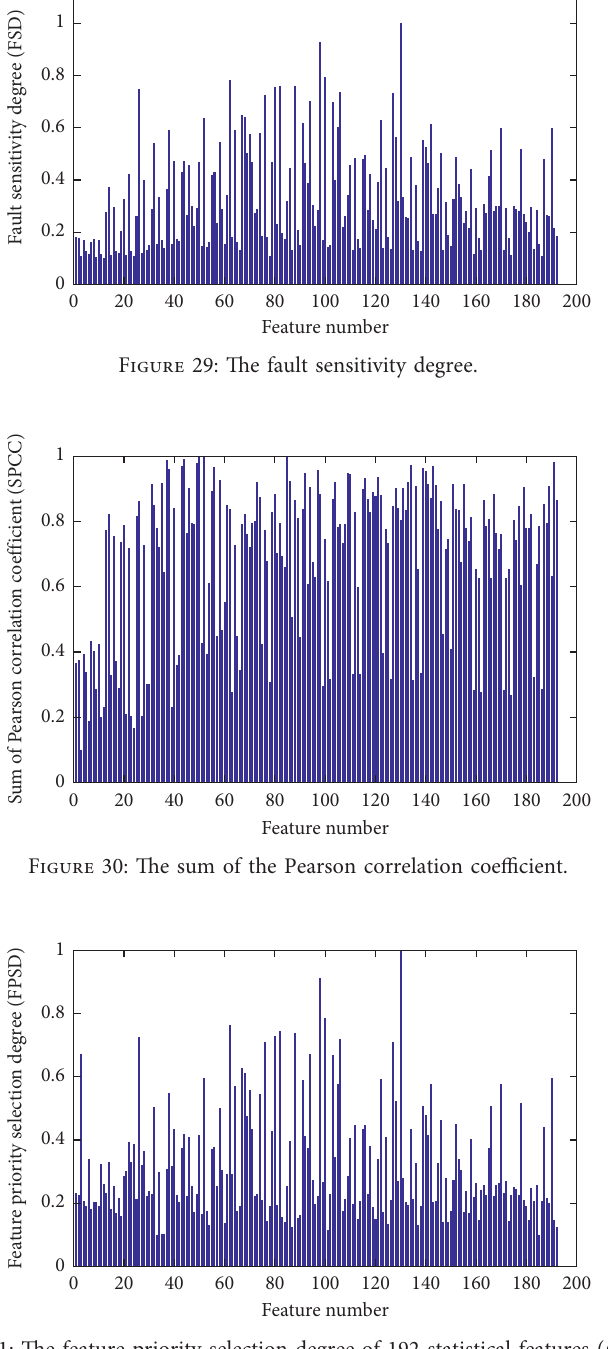
Figure 31: The feature priority selection degree of 192 statistical features ( μ � 0 .